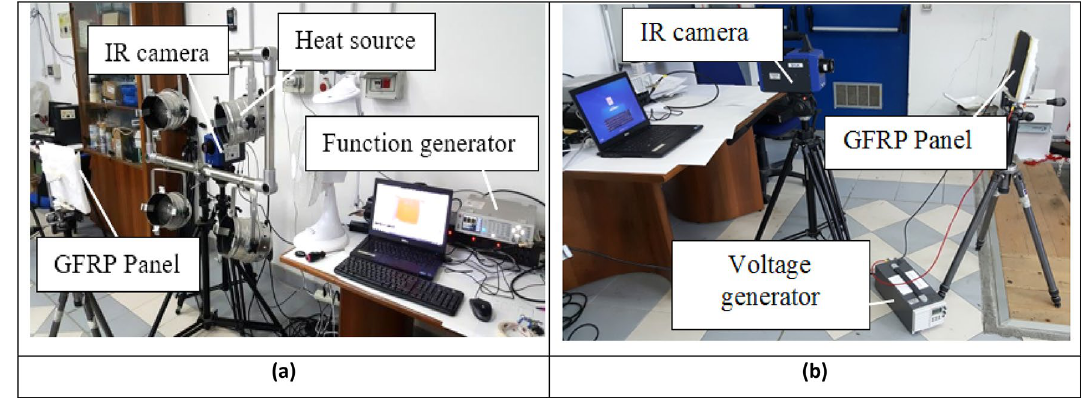
Fig. 3 Thermographic set-up: a traditional thermography and b SMArt